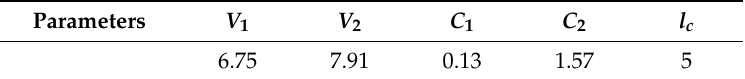
Table 1. Parameters value in Equation (5).